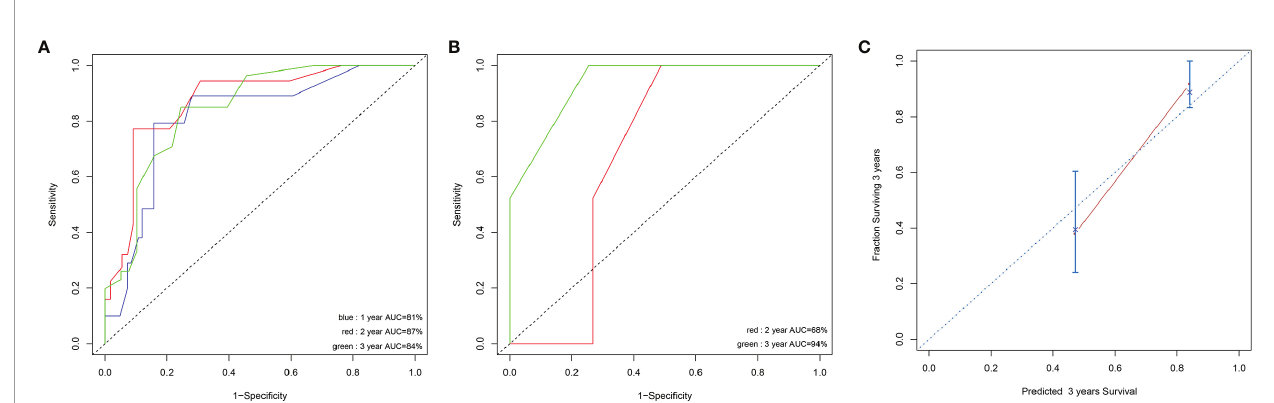
FIGURE 5 | Discrimination ability with the use of the receiver operating characteristic curve in the experimental cohort (A) and validation cohort (B) . Calibration curves for predicting OS of MDS patients at 3 years in experimental cohort (C) . The sum of these points is located on the total point axis, and a line is drawn downward to the survival axis to determine the likelihood of 1,2, or